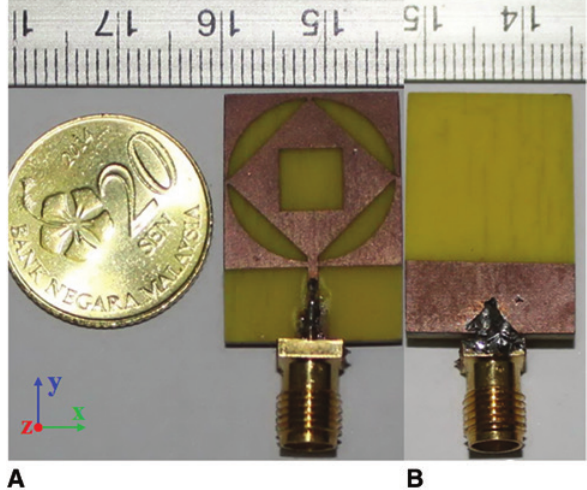
Figure 4: Photo of the fabricated antenna prototype: (A) top view and (B) bottom view.